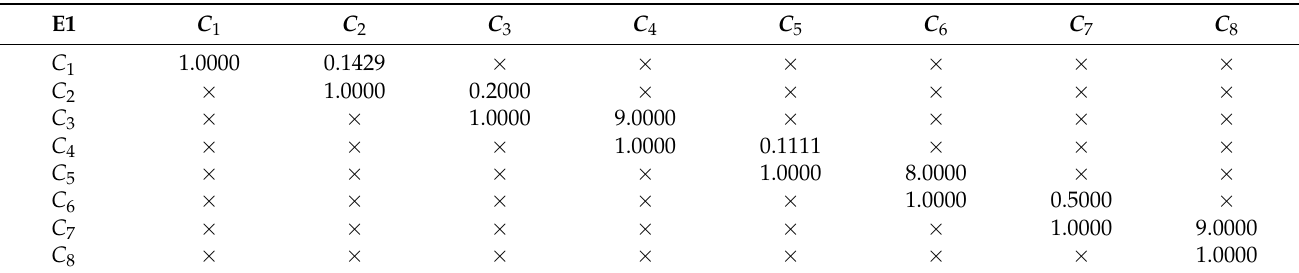
Table 3. Interval pairwise comparisons of the